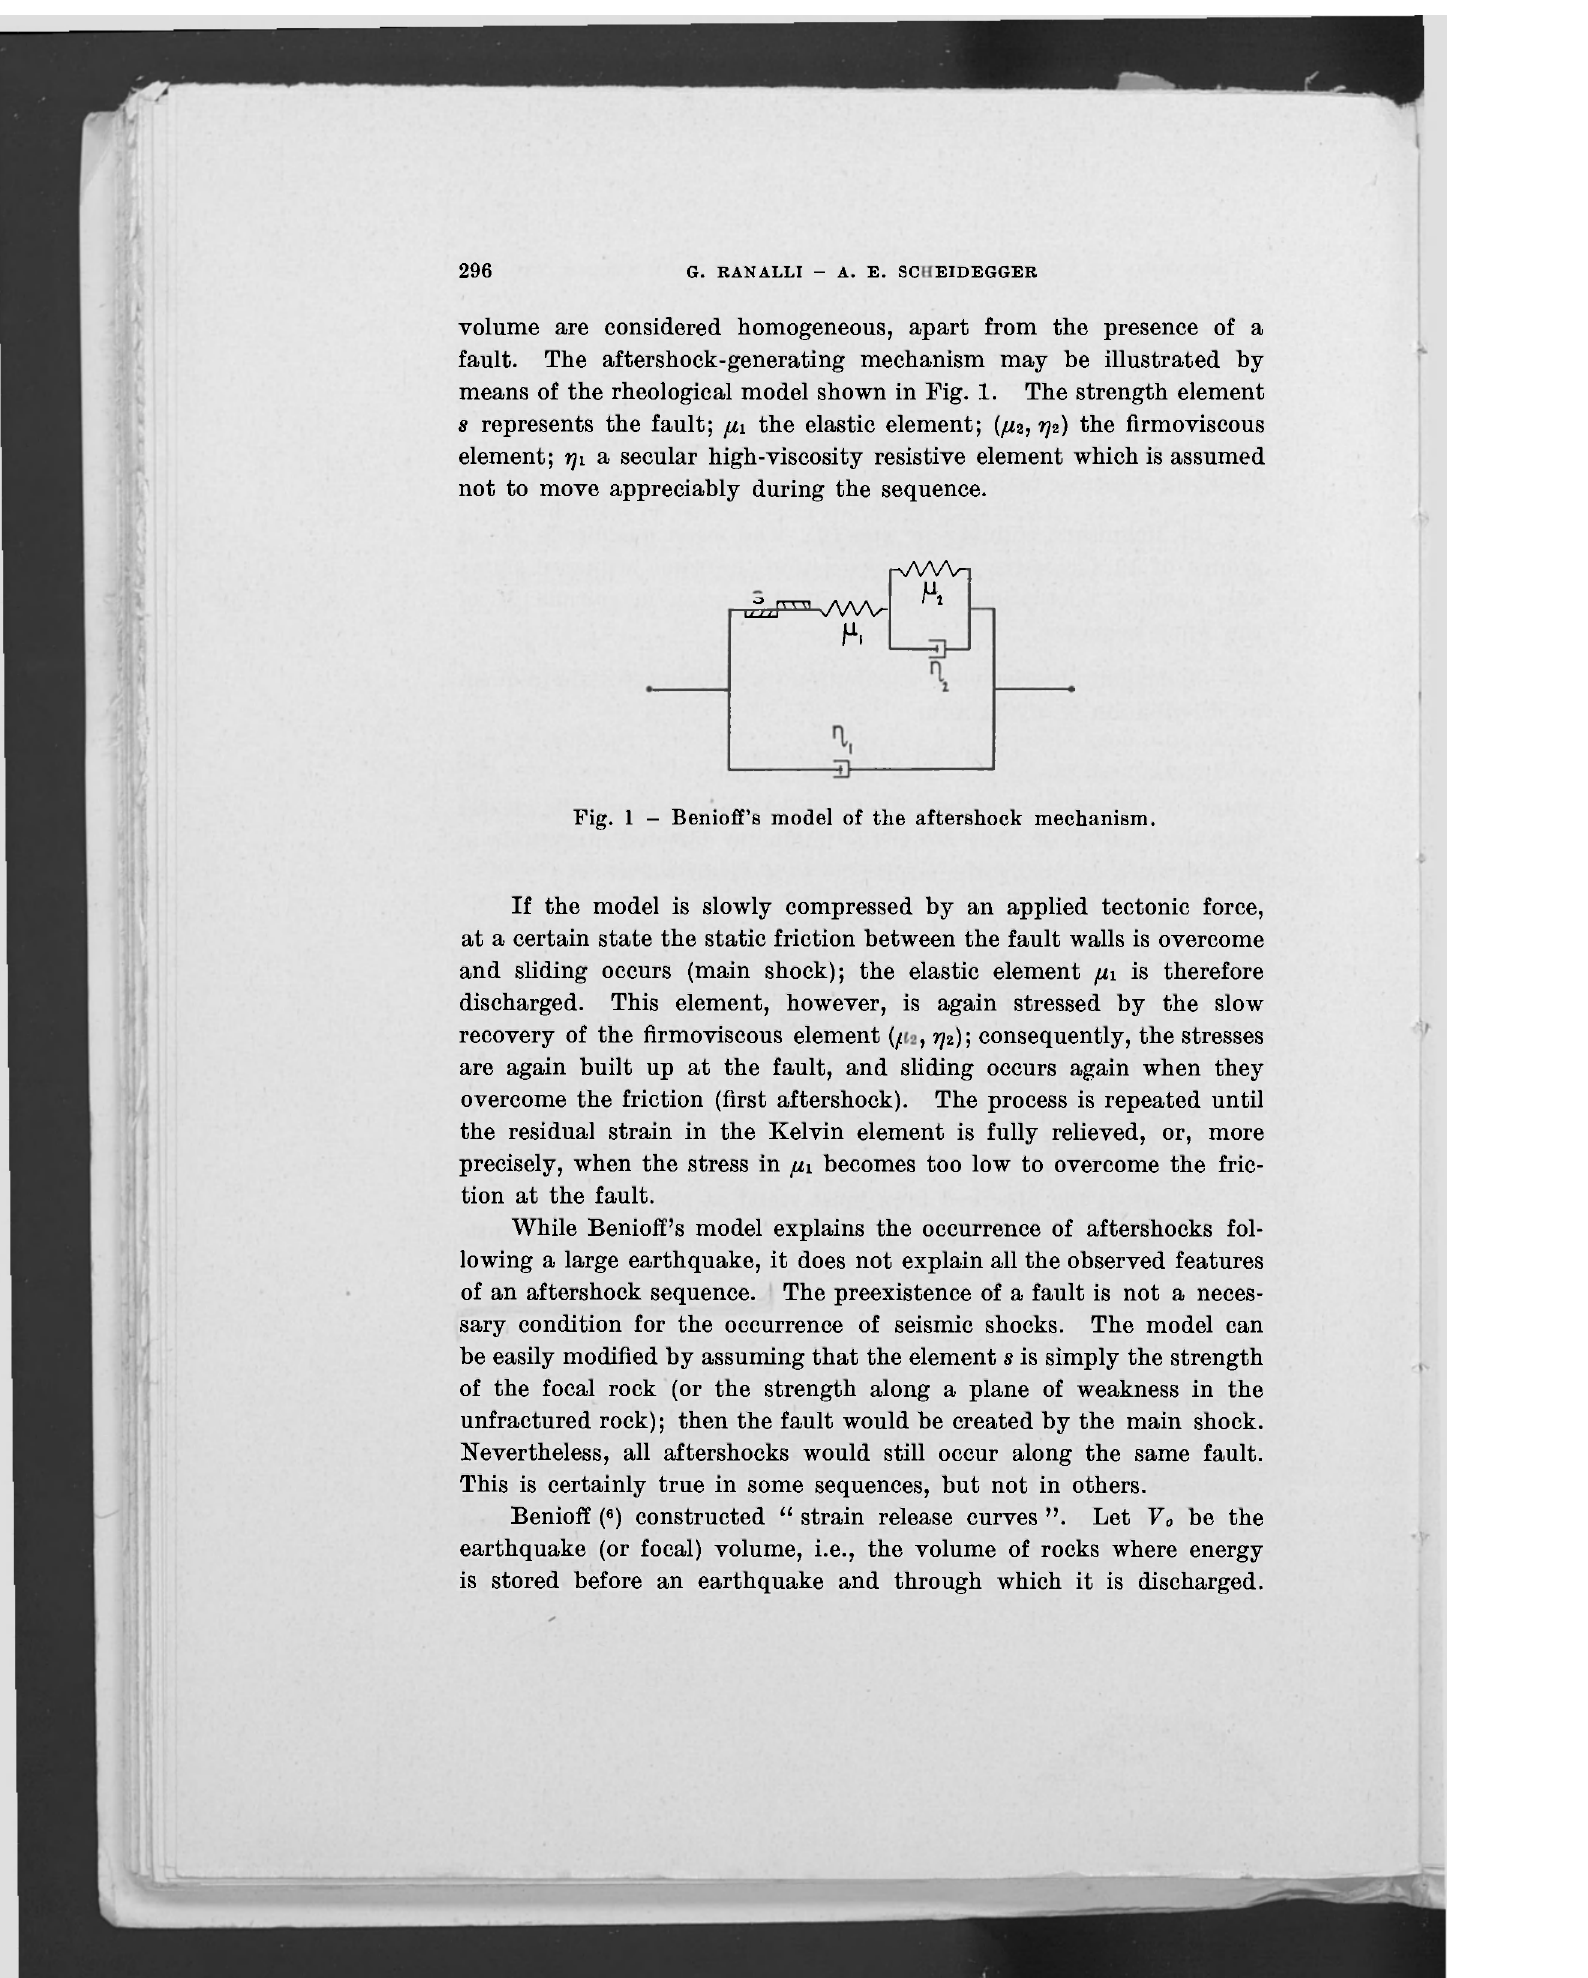
Fig. 1 - Benioff's model of the aftershock